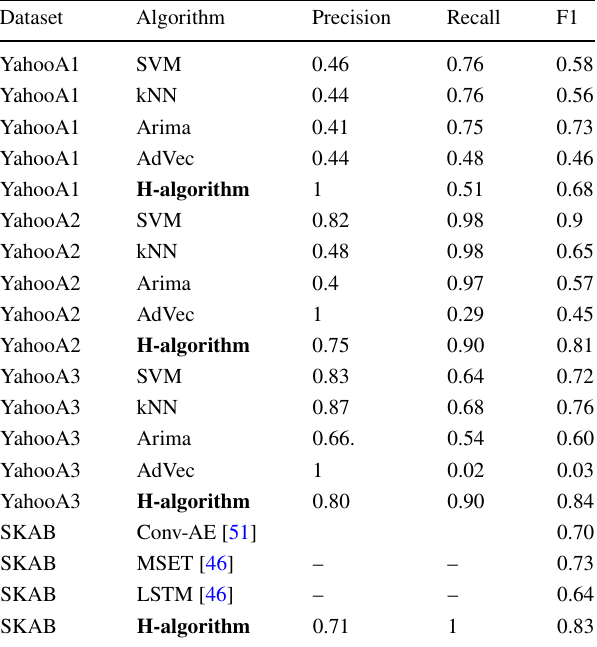
Table 8 Average performance on the data set groups for different algorithms [50] vs our hybrid algorithm (H-algorithm) Dataset